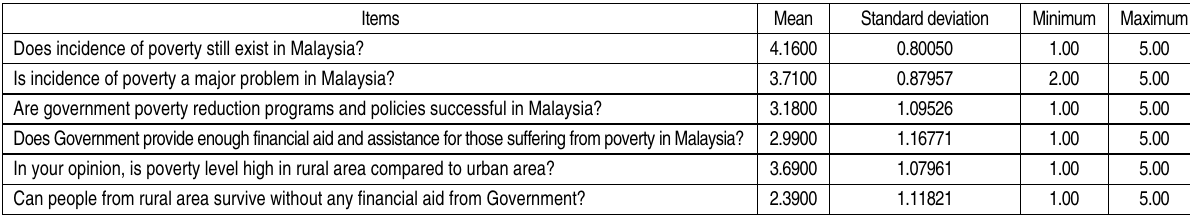
Table 4. Mean and standard deviation of poverty (N =